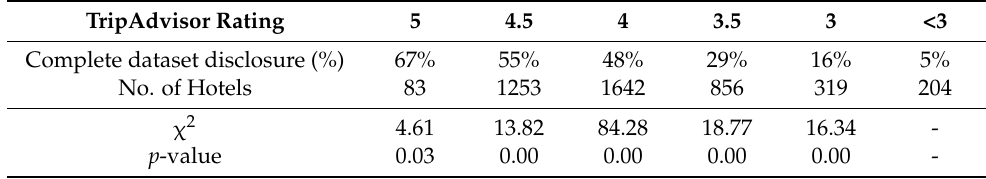
Table 3. Disclosure Rate by TripAdvisor Category—Combined